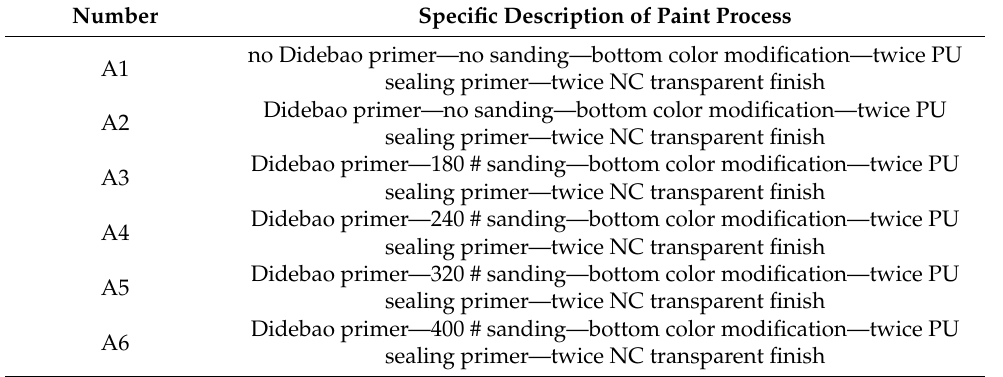
Table 1. The manufacture of specimens for Group